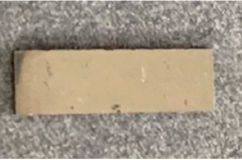
Figure 2. Sheet specimens cut from the middle sections of the Inconel 718 rods.